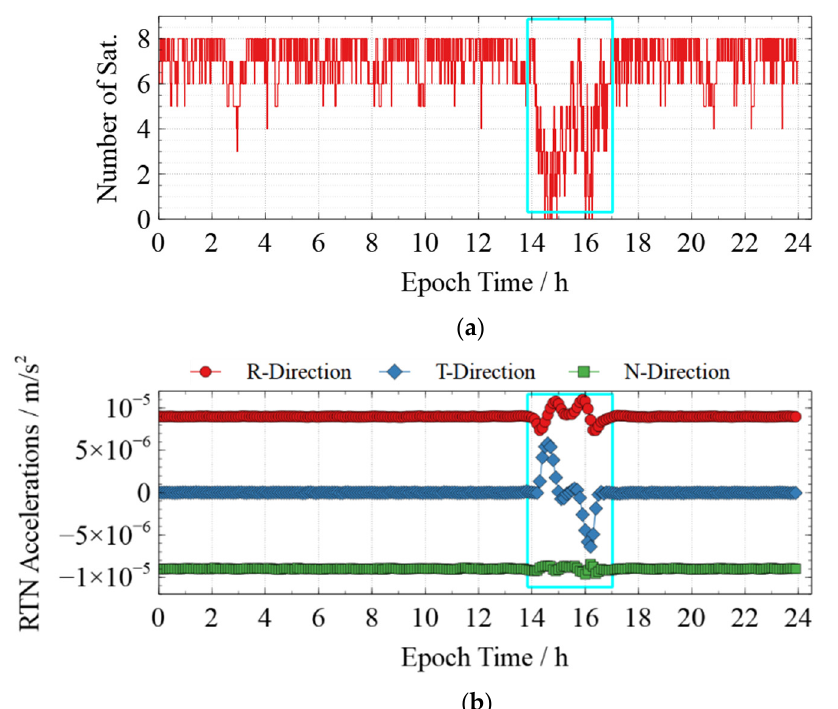
Figure 3. The number of observations and RTN accelerations in RDPOD for Swarm-C on DOY 162, 2021. ( a ) The number of tracked GPS satellites after data preprocessing for Swarm-C; ( b ) Estimated RTN accelerations of Swarm-C.